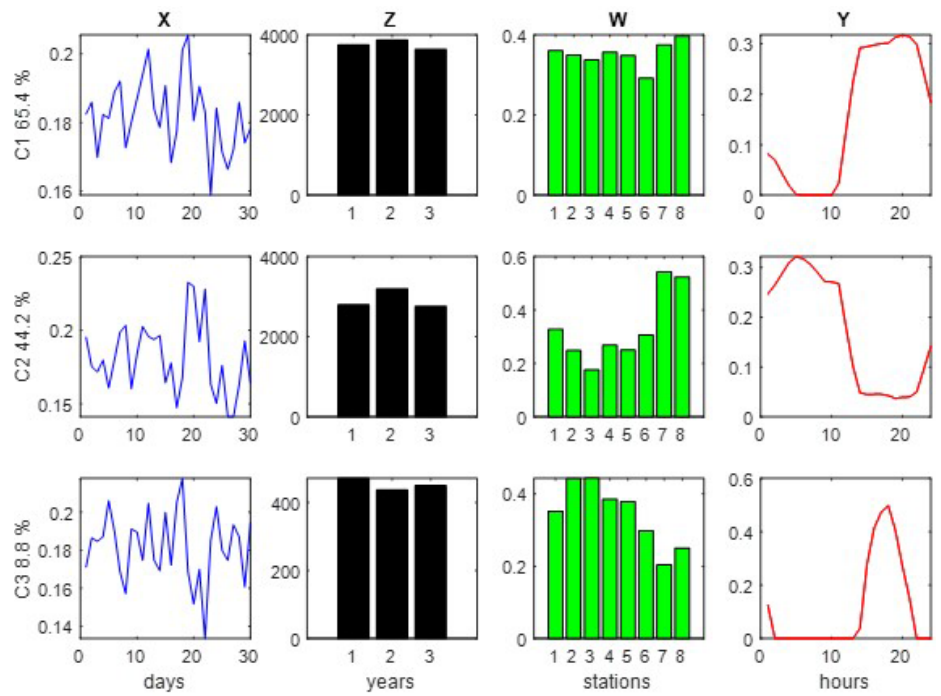
(Eq. 3) using non- 3